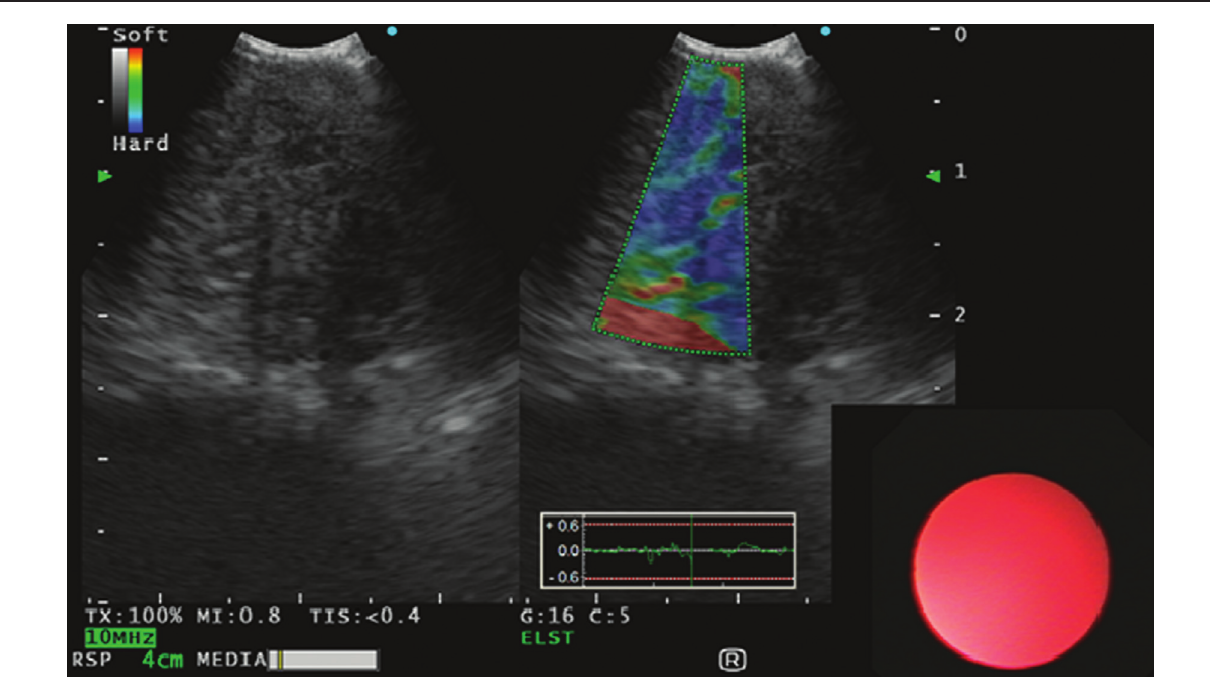
Type 3 can be seen on the elastography image.